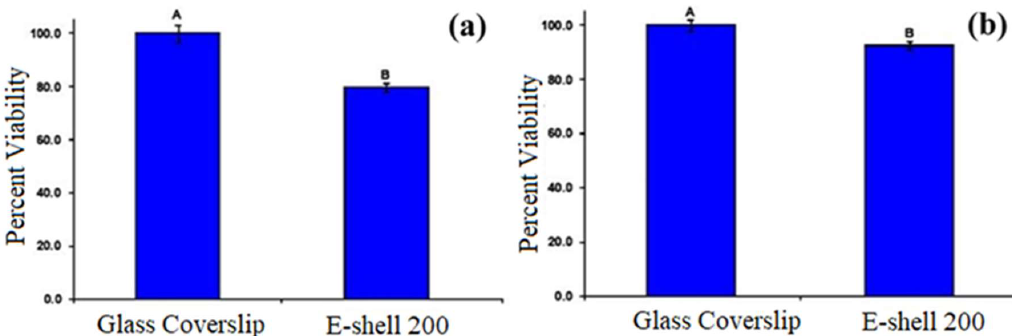
Figure 15. MTT viability data for cells grown on e-shell 200 acrylate-based polymer and glass cover slip. ( a ) MTT viability of human epidermal keratinocytes grown on e-Shell 200 acrylate-based polymer compared to glass cover slip. A and B denote statistical differences p < 0.05 between the polymer and the control. ( b ) MTT viability of human dermal fibroblasts grown on e-Shell 200 acrylate-based polymer compared to glass coverslip. A and B denote statistical differences p < 0.05 between the polymer and the control [42].